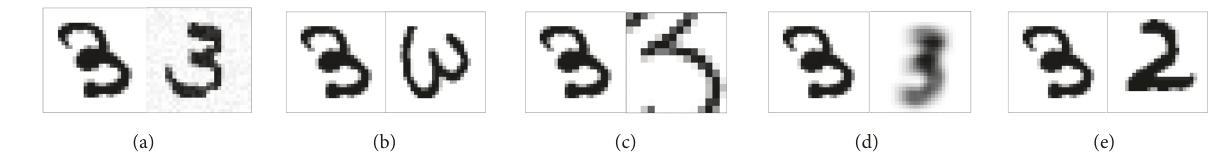
Figure 2: Pairs of images that are representative of the transformations classified into five labels: (a) very similar, (b) rotated by 90 ∘ , (c) zoomed, (d) blurred, and (e) different.